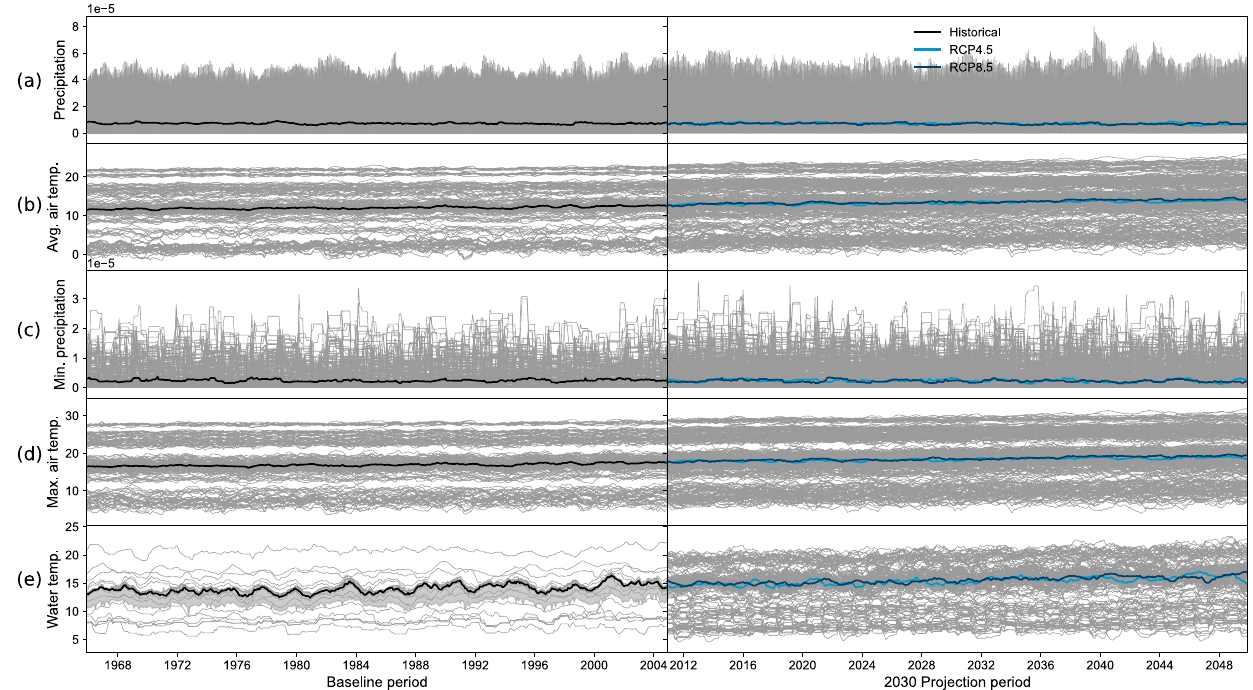
Fig. 3 Precipitation, air temperature, and water temperature trends from baseline to the 2030 projection period. a shows precipitation, b average air temperature, c minimum precipitation, d maximum air temperature, and e water temperature. Gray lines represent simulations by a climate model, by scenario, and by power plant. Black and blue lines are the ensemble medians of historical values and projections under RCP4.5 and RCP8.5.